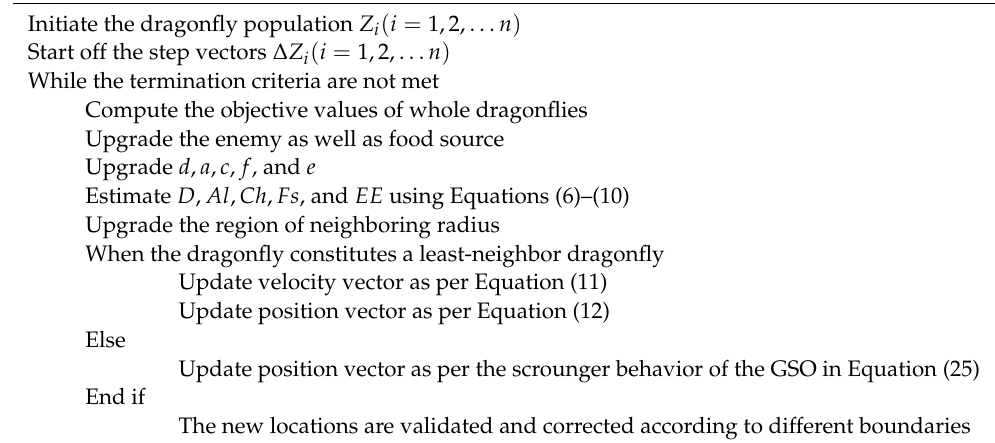
Algorithm 3: Pseudo code of proposed SL-DA algorithm